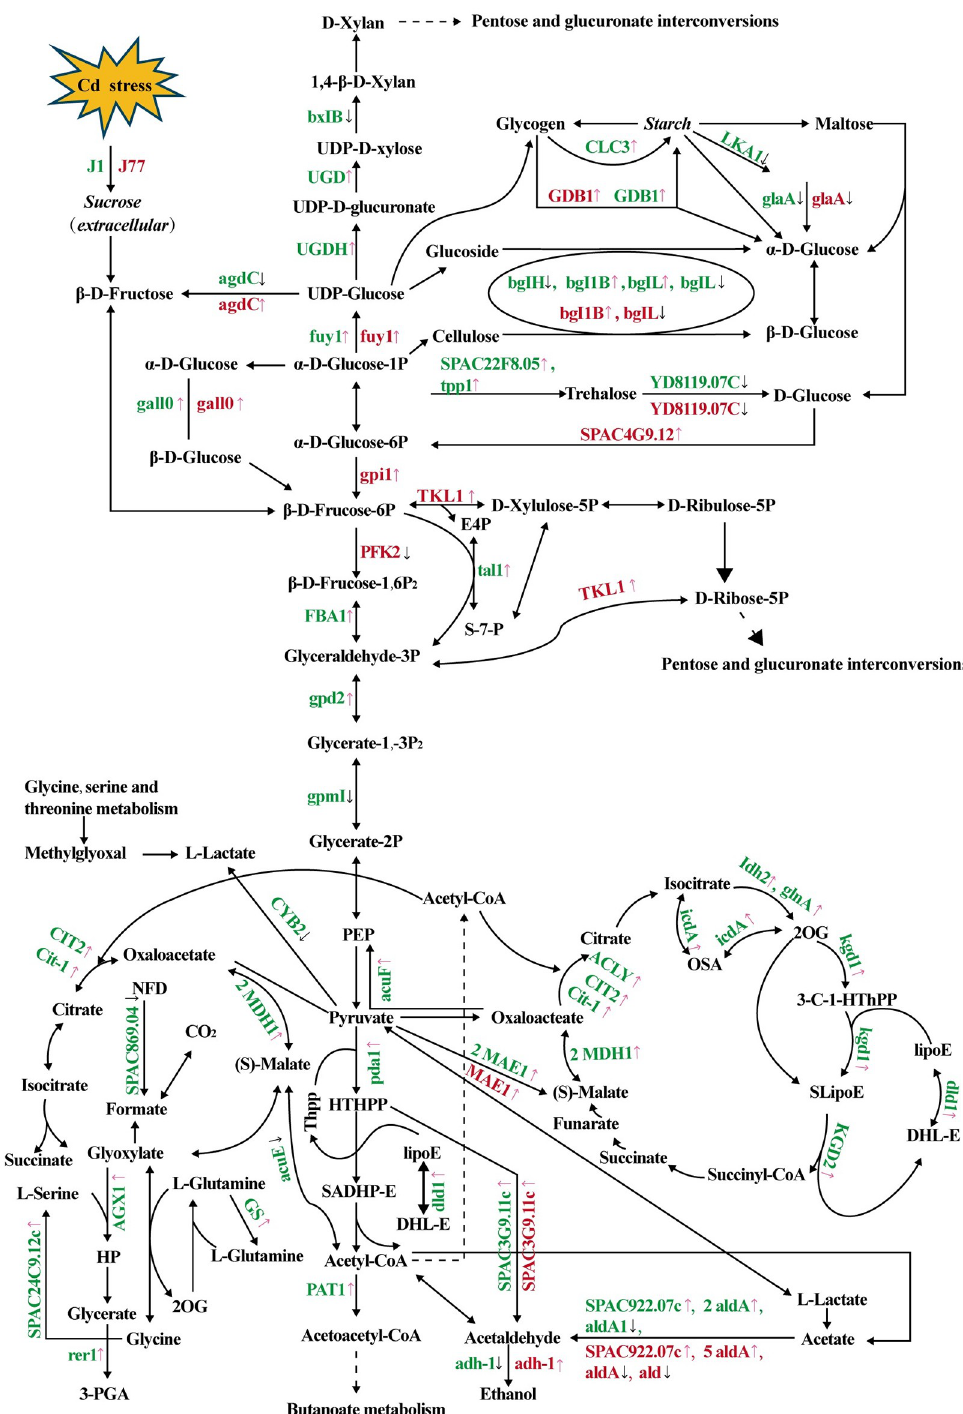
Fig 4. DEGs involved in starch and sucrose metabolism (ko00500), pentose phosphate pathway (ko00030), glycolysis/ gluconeogenesis (ko00010), TCA cycle (ko00020), glyoxylate and dicarboxylate metabolism (ko00630), pyruvate metabolism (ko00620) in Cd2- and/or Cd5-treated J1 and J77 mycelia. Pink arrow: upregulation; Dark arrow: downregulation; ACLY: probable ATP-citrate synthase subunit 1; ald: aldehyde dehydrogenase family; bgl1B: β - glucosidase 1B; 3-C-1-HThPP: 3-carboxy-1-hydroxypropyl-Thpp; DHL-E: dihydrolipoamide-E; E4P: D-erythrose-4P; GS: gutamine synthetase; HP: hydroxypyruvate; HTHPP: 2-hydroxyethyl-ThPP; lipoE: lipoamide-E; OSA: oxalosuccinate;